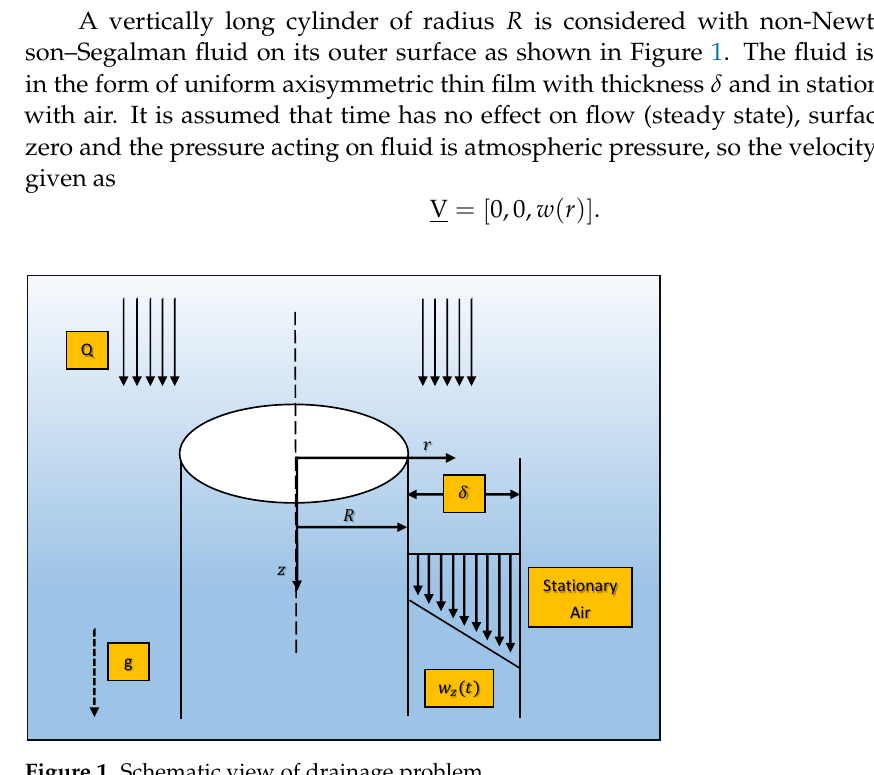
Figure 1. Schematic view of drainage problem. Radial direction is considered parpendicular to cylinder while z-axis is in downward direction horizontal to cylinder as prescribed in Figure 1. Boundary conditions for